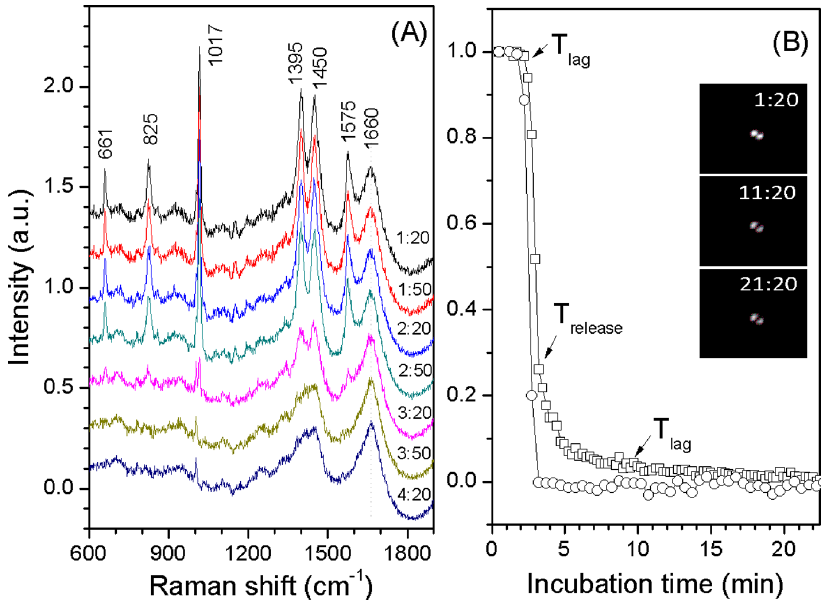
Figure 2. Dynamics of nutrient germination of an optically trapped individual G.stearothermophilus spore. A heat activated (30 min, 100 u C) spore was germinated at 65 u C with 0.1 mM L-valine in 10 mM sodium phosphate buffer (pH 8.0), and the spore was monitored by Raman spectroscopy and DIC microscopy as described in Methods. Time-lapse Raman spectra of the trapped spores after the addition of L-valine were shown in (A). The indicated peaks at 661, 825, 1,017, 1,395 and 1,575 cm 2 1 are the CaDPA bands. Normalized intensities of the CaDPA band at 1017 2 1 ( # ) and DIC images ( % ) as the function of incubation time were shown in (B). The CaDPA band intensities and DIC image intensities were normalized to their initial values right after the addition of L-valine, and the DIC image intensity at 25 min was normalized to 0. The interval between Raman spectrum acquisitions was 30 s, and the interval between DIC image acquisitions was 15 s. The inserts in Fig. 2(B) are the time-lapse DIC images of the trapped spore with a scale bar of 2 m m. The DIC image of a single spore appears as two bright spots in DIC microscopy.